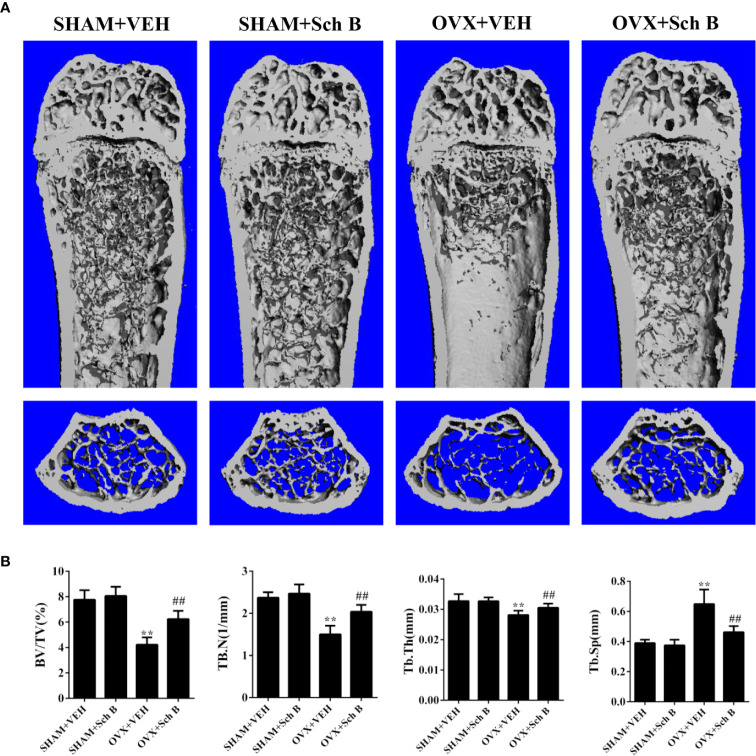
Schisandrin B attenuates ovariectomy-induced bone loss. (A) Representative micro-CT reconstruction results of the indicated four groups. (B) Micro-CT analyses of BV/TV, Tb.N, Tb.Th, and Tb.Sp in the region of interest. Data are presented as means ± SD. **P < 0.01 versus the SHAM+VEH group. ##P < 0.01 versus the OVX+VEH group.